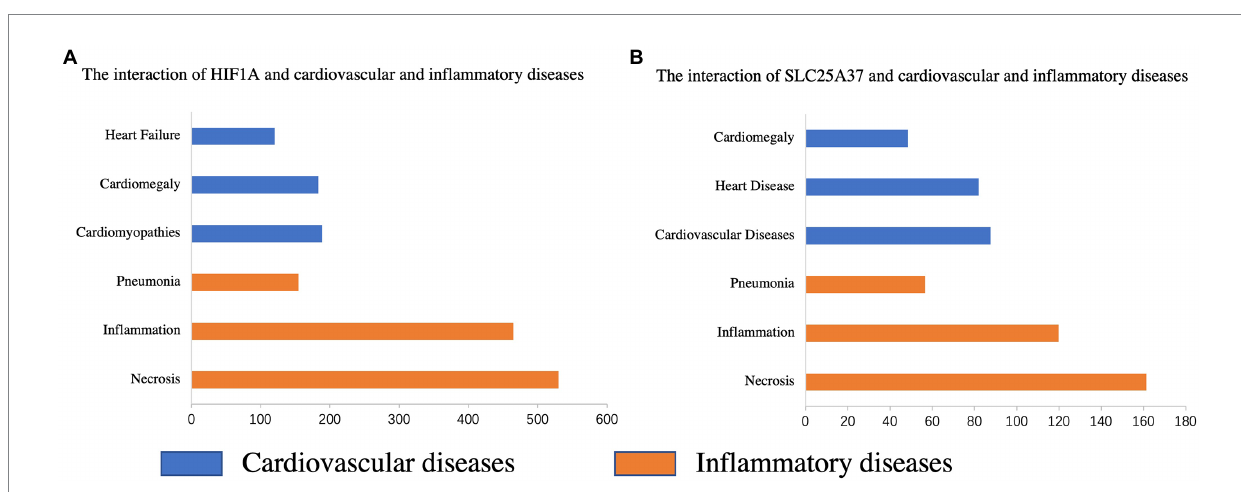
FIGURE 7 Relationship between the genes of the prognostic model and various diseases based on the comparative toxicogenomics database (CTD). Interactions between HIF1A (A) and SLC25A37 (B) and cardiovascular and inflammatory diseases,